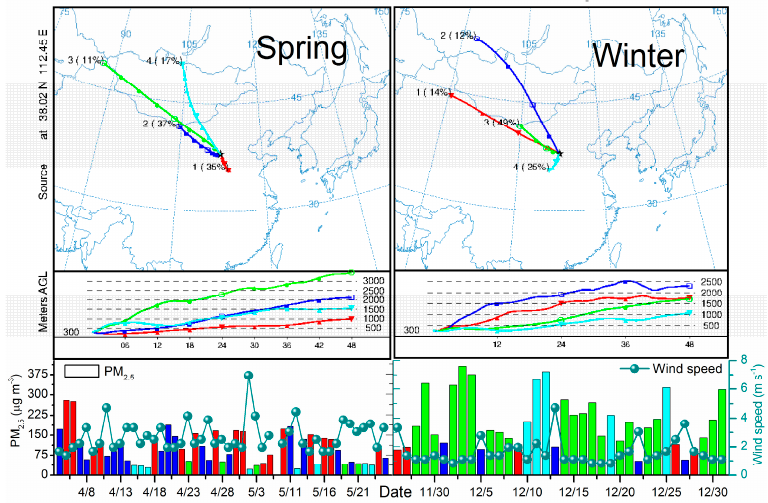
Figure 2. The back trajectory cluster analysis and corresponding PM 2.5 concentrations and wind speeds at NUC during the spring and winter of 2016.